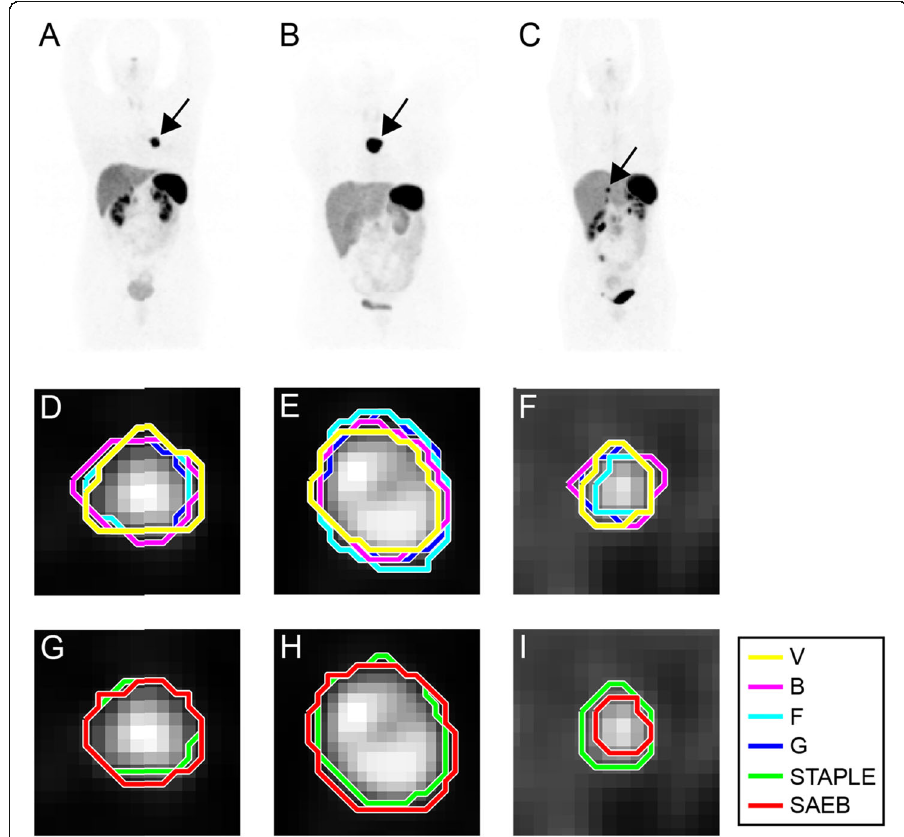
Fig. 3 Example of segmentation (single slice images) of lesions extracted from three different examined patients. Panels a , d , and g show a lung primary NET; panels b , e , and h show metastatic lesion in a mediastinal lymph node; panels c , f , and i show a metastatic liver lesion. The first row shows the maximum intensity projection (MIP) of 68 Ga-DOTATOC of the three different patients where black arrows point at the segmented lesions. In the second row, manual contours performed by the four operators are represented in different colors. The third row shows the STAPLE contour (in green) and the semi-automatic edge-based segmentation (SAEB) algorithm result (in